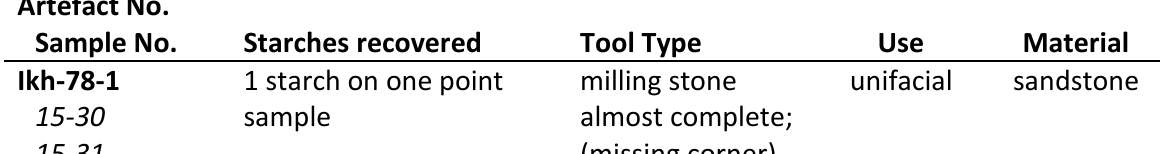
Table 2. Starches recovered from milling